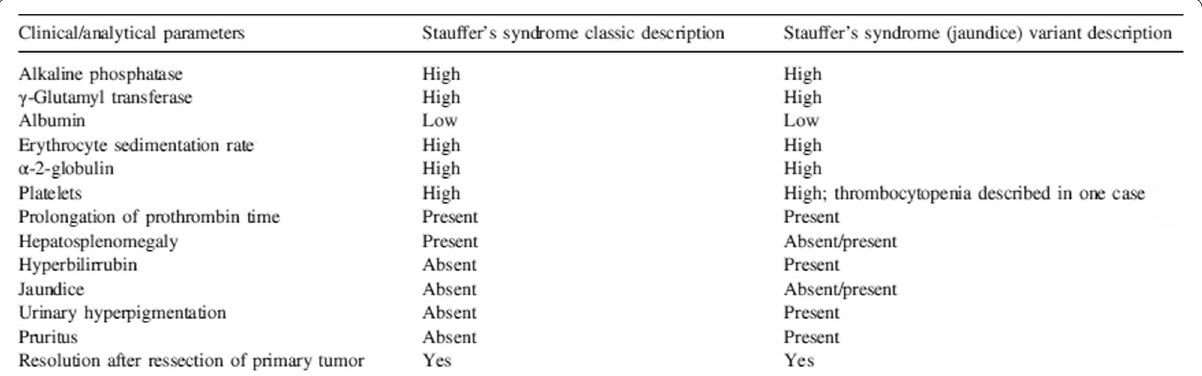
Fig. 1 Clinical/analytical parameters for Stauffer’s syndrome